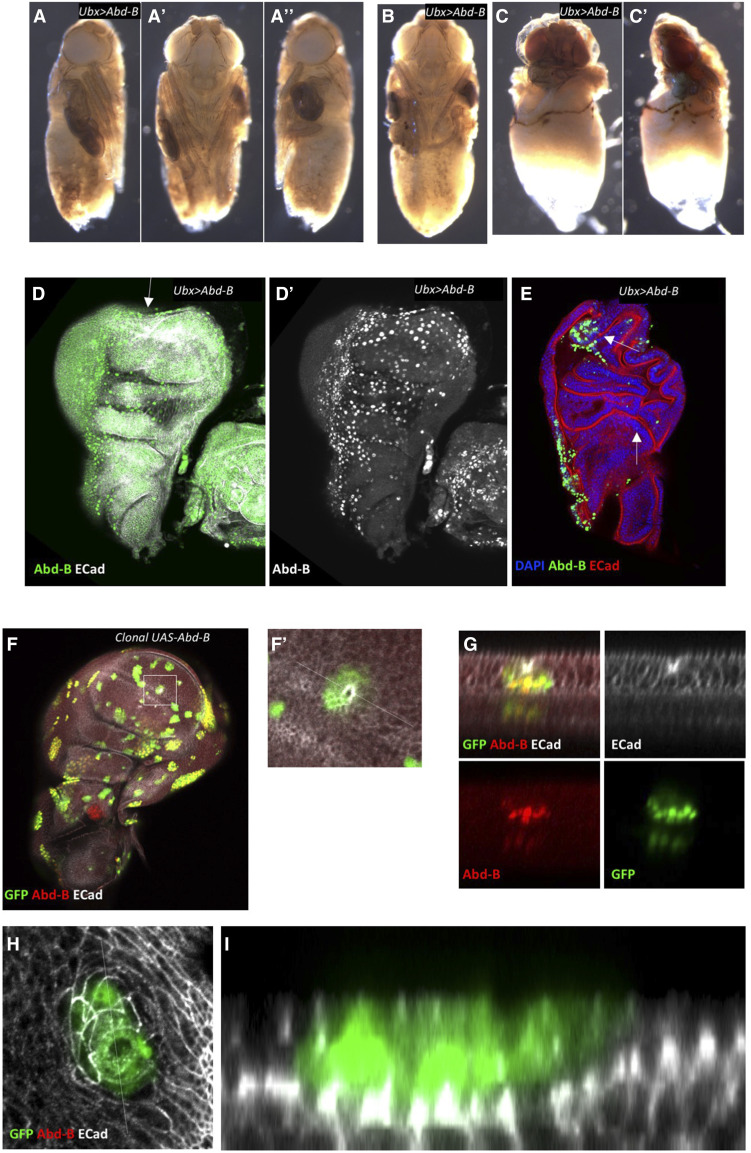
Abd-B affects epithelial cells and wing morphology. (A-C) Pharate adults showing eversion phenotypes. The primary phenotype was for one or more malformed and mispositioned wings (A’, A’’). (B) An adult with both wings affected, and legs malformed. (C) Adult with a more severe phenotype in which the thorax is disrupted and only one wing has everted, but is malformed. (D) Expression of Abd-Bm with the Ubx-GAL4 driver induces strong expression of Abd-B throughout the PE (D’) but some regions of expression in the DP cells in the wing blade also robustly express Abd-B. Wing discs show a range of morphological disruption ranging from mild depressions (D, arrow) to more substantial folding (E, arrows). (F-I) Clonal expression of Abd-Bm creates regions of epithelial invagination. (F) A small clone of Abd-Bm expressing cells has folded inwards to produce a depression. (G) Cross-section of dotted line in F’. (H) A clone of Abd-Bm expressing cells in the PE creates a depression of the underlying DP epithelium. (I) Cross-section of dotted line in H. Error bars = 95% confidence interval (Wilson score method).